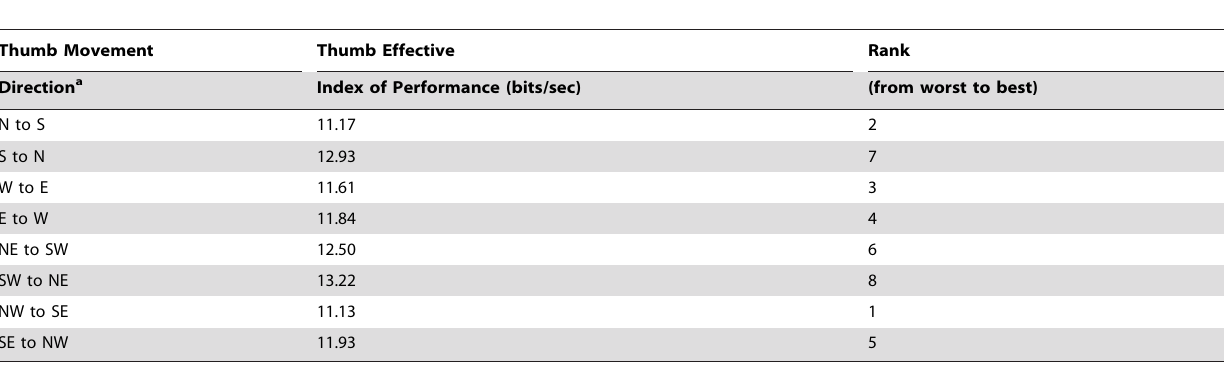
Table 1. Average values for effective index of thumb performance (bits/sec) and their rank for each thumb movement direction, used in the calculation of the movement direction performance index (Trudeau et al., 2012a and Trudeau et al., 2012b).